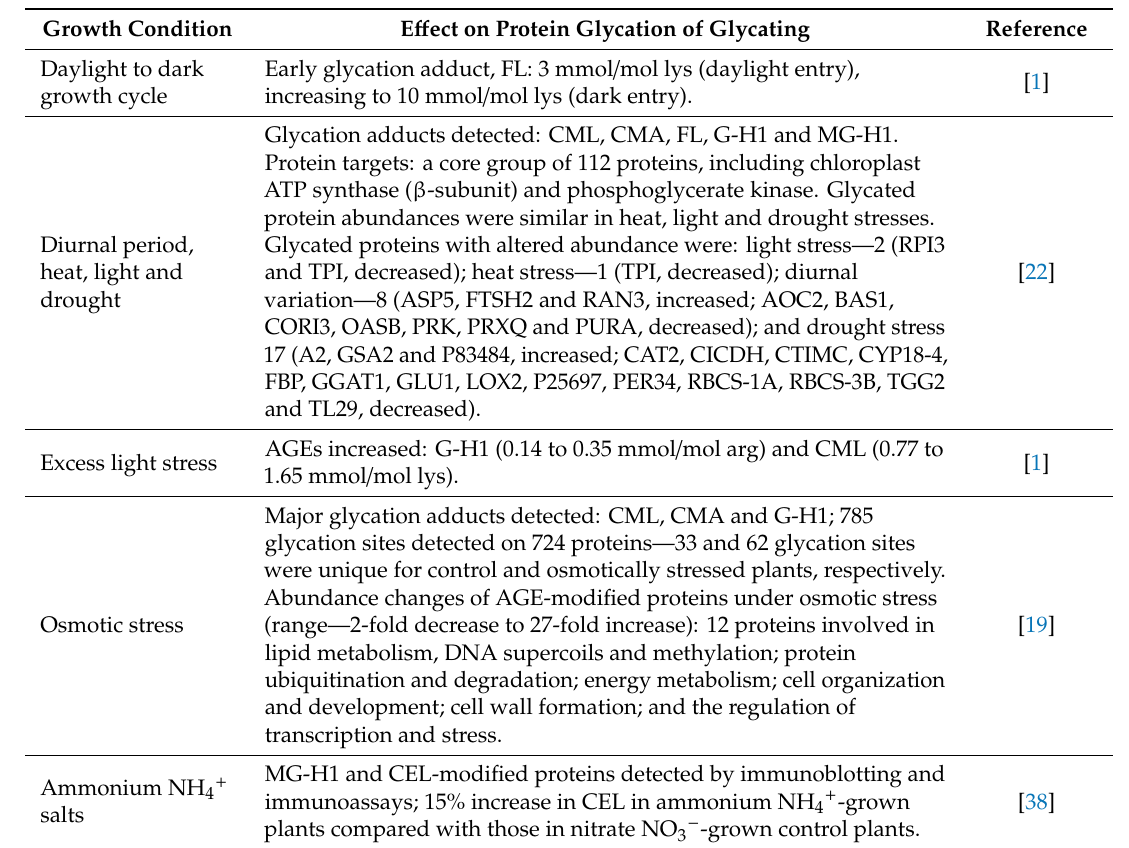
Table 1. E ff ect of growth conditions on protein glycation in Arabidopsis thaliana